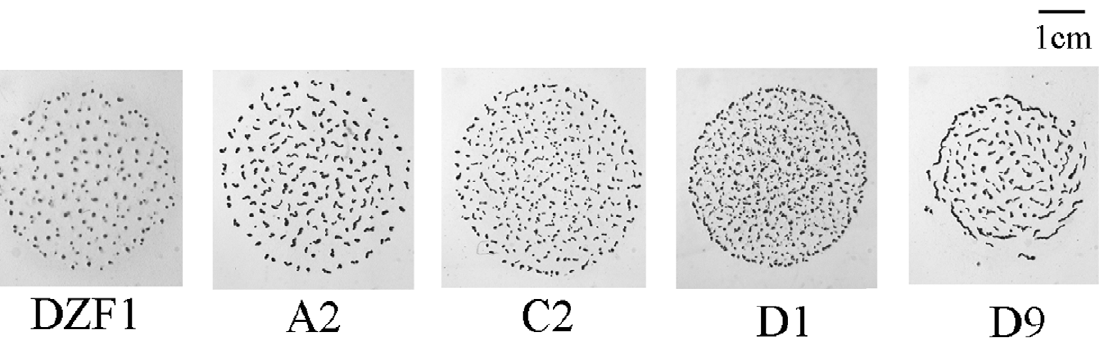
Figure 4. Phenotypic diversity after 72 h development of Myxococcusxanthus parental strain and knock-out mutants. Solid dark spots correspond to mature fruiting bodies containing myxospores after aggregation and differentiation of vegetative cells. Observed diversity results from knocking out genes associated with changes in developmental timing. Micrographs were taken at 269.5 pixel/mm on TPM plates.